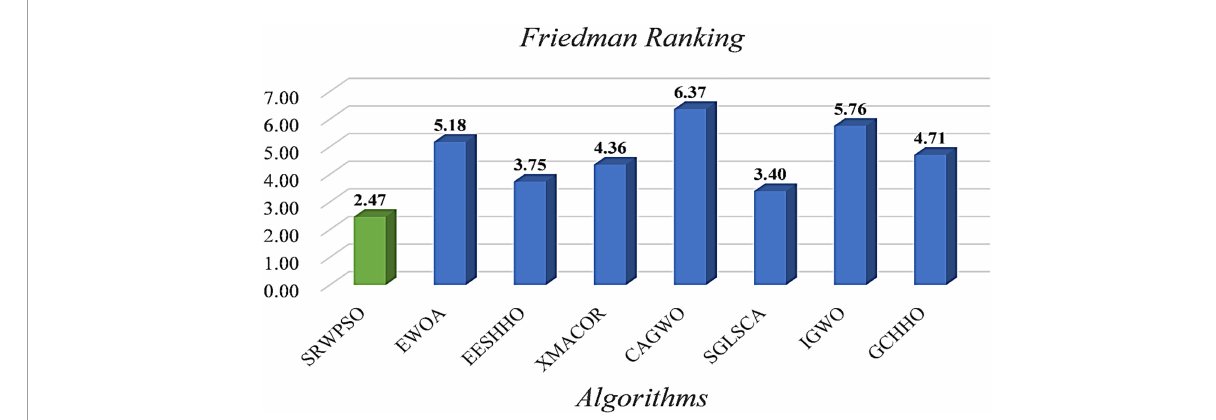
FIGURE13 The results of Friedman test of SRWPSO with new peer variants.